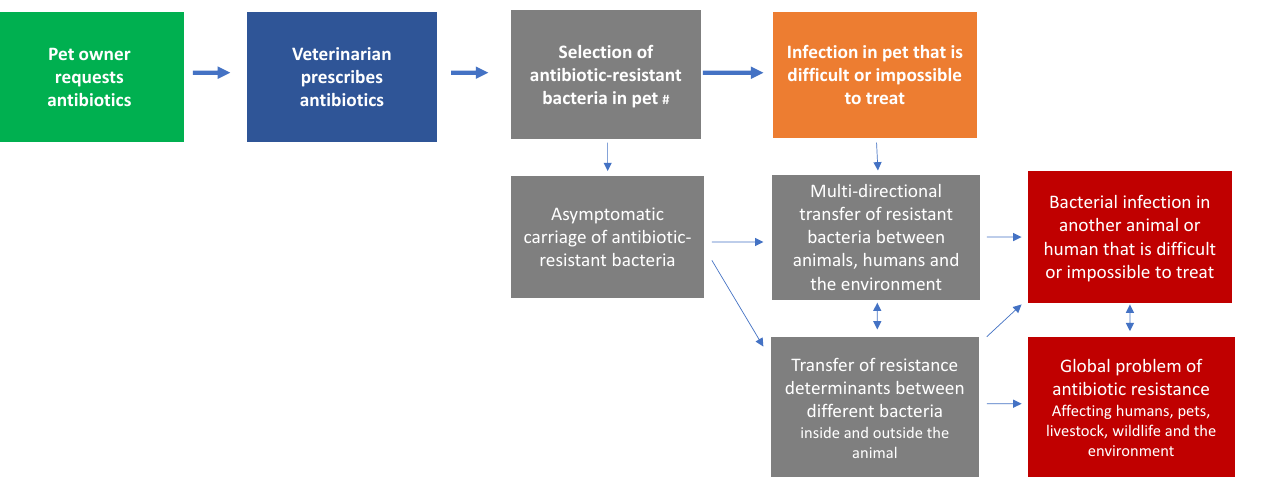
Figure 13. Owner behaviour (green) and public health outcomes (red) are linked by microbiological concepts (grey) that are poorly understood. The more direct potential adverse outcome for the pet (orange) is simpler to communicate, and remains logical even if the pet owner holds the # common misconception that antibiotic resistance is a property of the animal’s